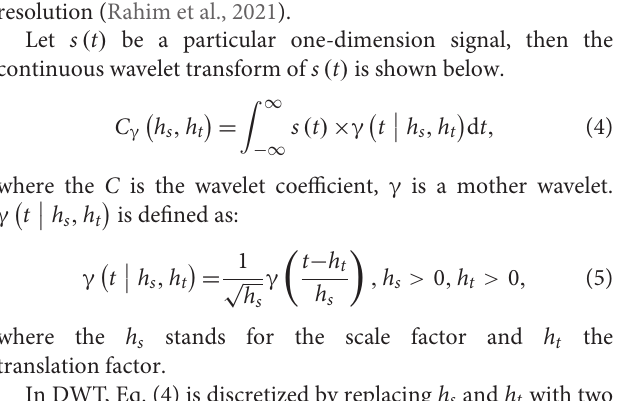
representation, DWT is advantageous in multiscale time/space resolution (Rahim et al.,